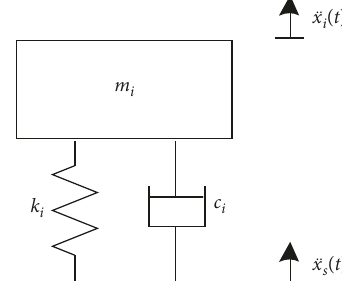
Figure 3: The dynamic model of the SDOF